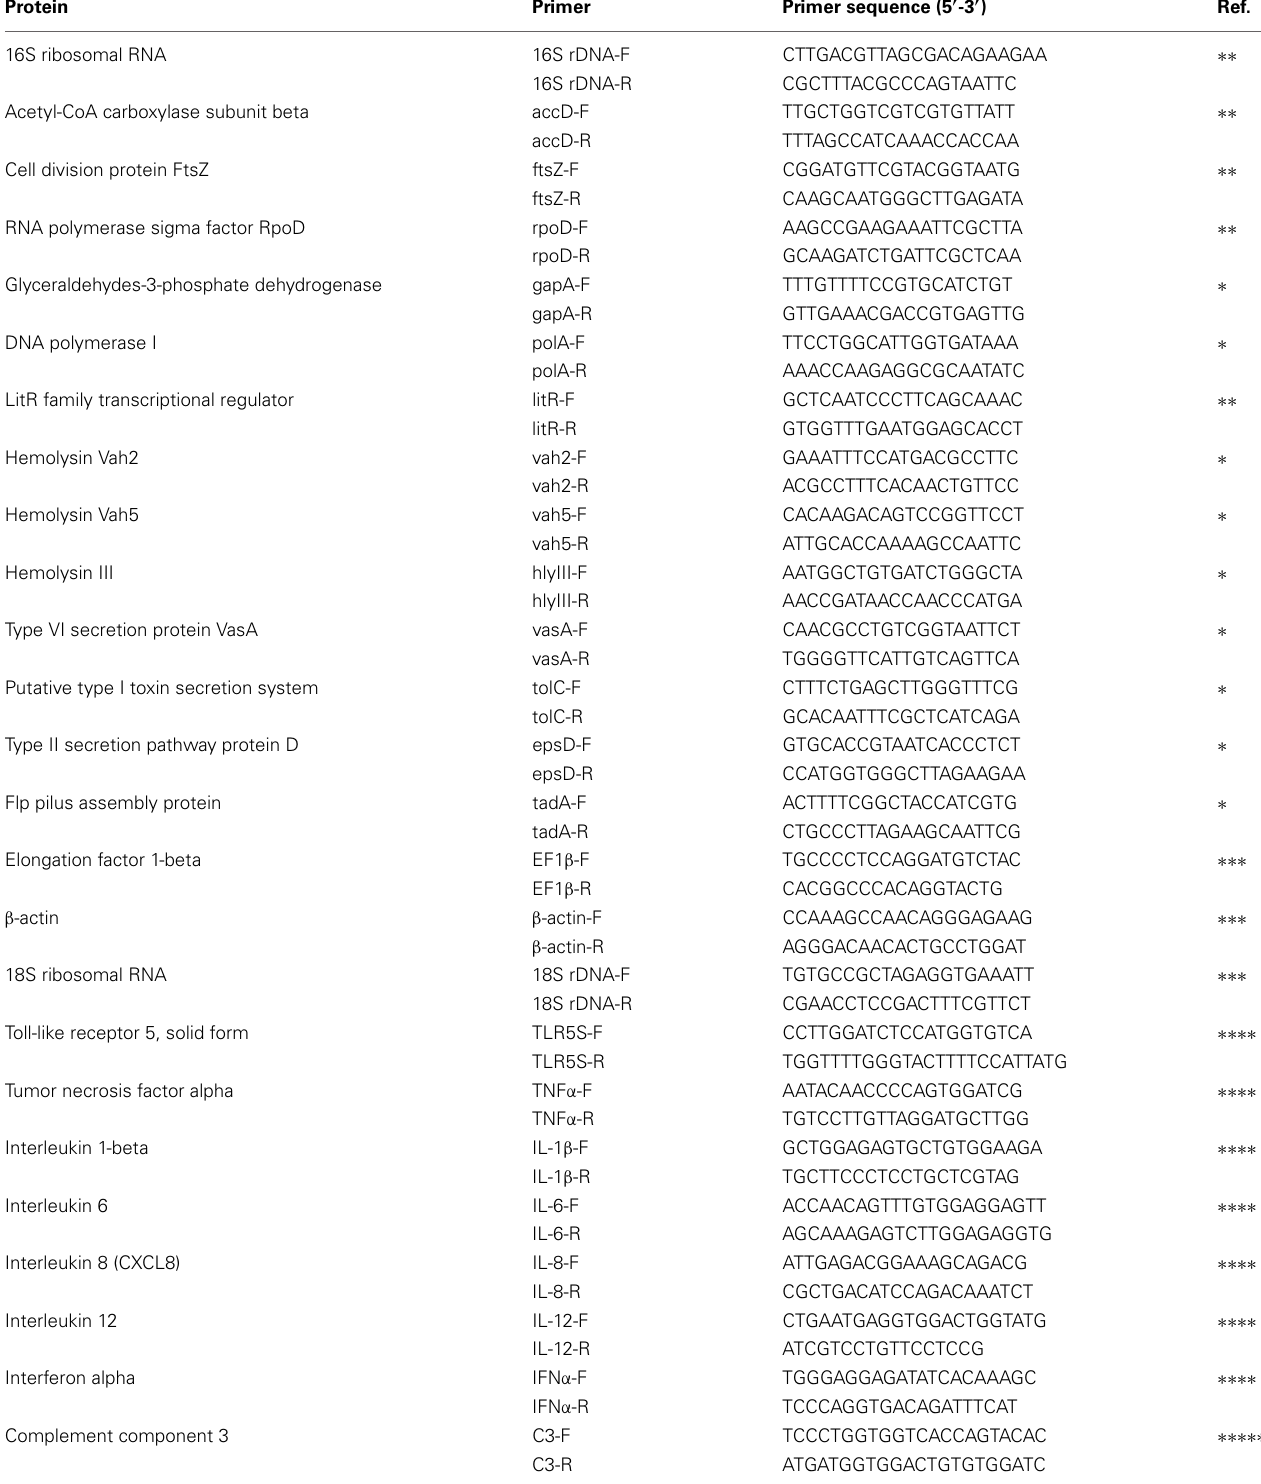
Table 1 | Primers used in this study.